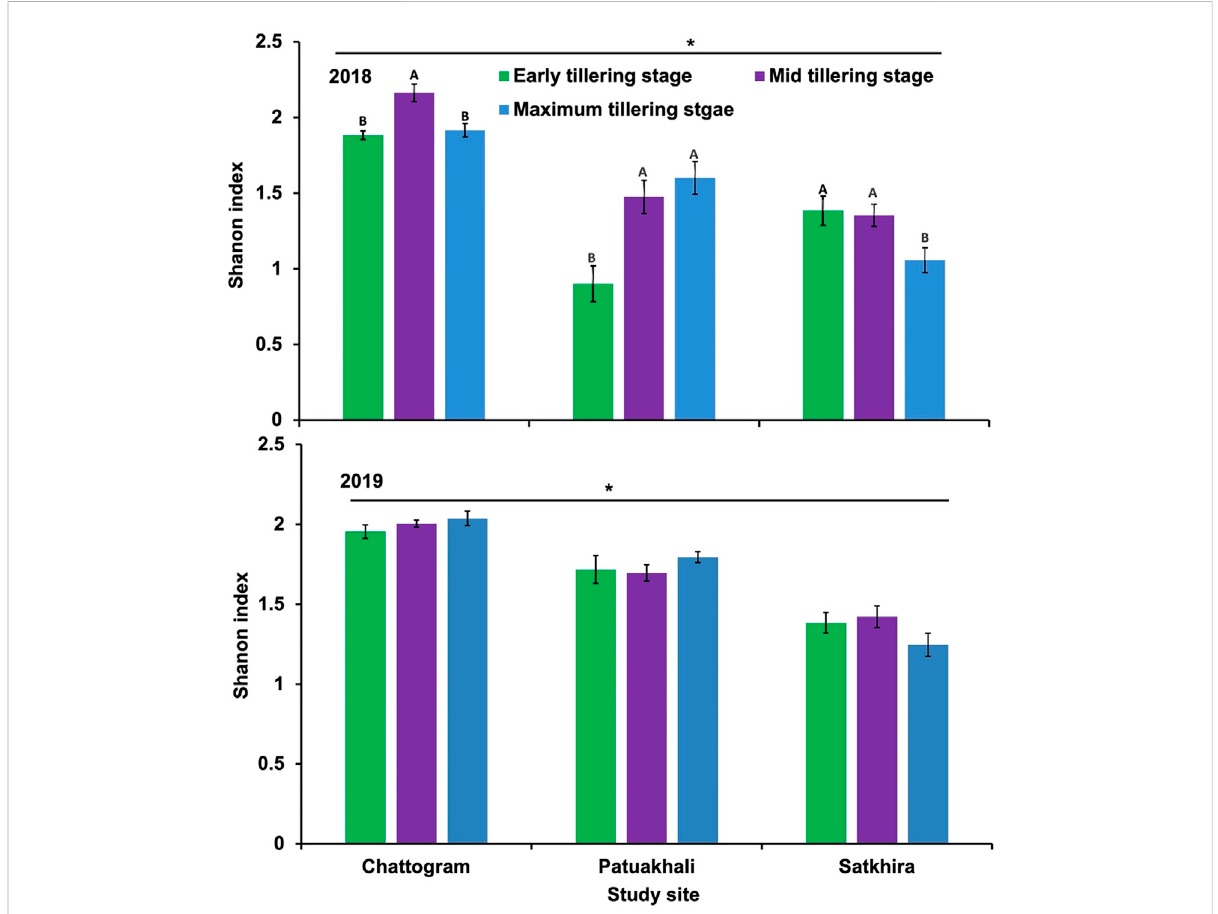
FIGURE 2 Comparative graphical representation of species diversity index (Shanon index) in three geographic locations. Diversity measured at early tillering stage, mid tillering stage and maximum stage of 2018 (upper fi gure) and at early, mid, and maximum tillering stage, which have increased in 2019 (lower Figure 2. Notably, early tillering in Patuakhali increased the most while Satkhira seems constant (albeit with an increased maximum tillering stage). In Chattogram mid tillering stage has decreased in 2019, while overall diversity mean values increased, i.e. mixed nature of land